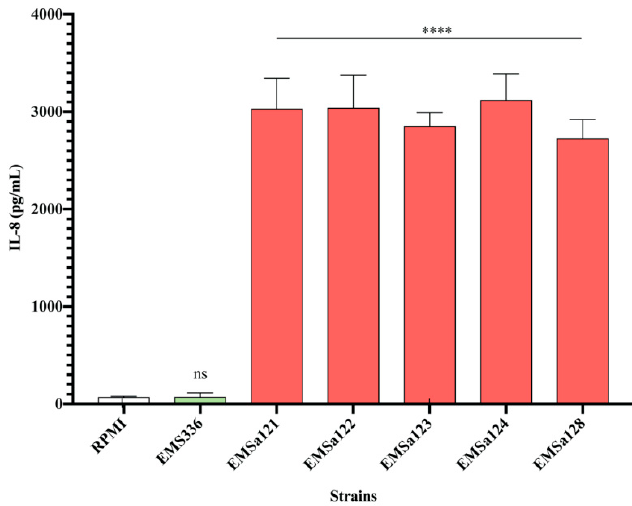
Figure 2. IL-8 produced by the BEAS-2B cells in response to primo-colonizing Staphylococcus strains. All strains of Staphylococcus (EMSa) and Streptococcus (EMS) were isolated from the buccal cavity of human newborns. Staphylococcus was isolated on the first day of life. For the challenge assay, BEAS-2B cells were co-incubated with bacterial strains (MOI of 100:1) for 6 h in 24-well plates. IL-8 was quantified by using ELISA immunoassays. Data are the mean of secreted IL-8 (pg / mL) ± SEM of at least two biological replicates (with two technical replicates each). p -values: *: p < 0.03, **: p < 0.002, ***: p < 0.0002 and ****: p < 0.0001.